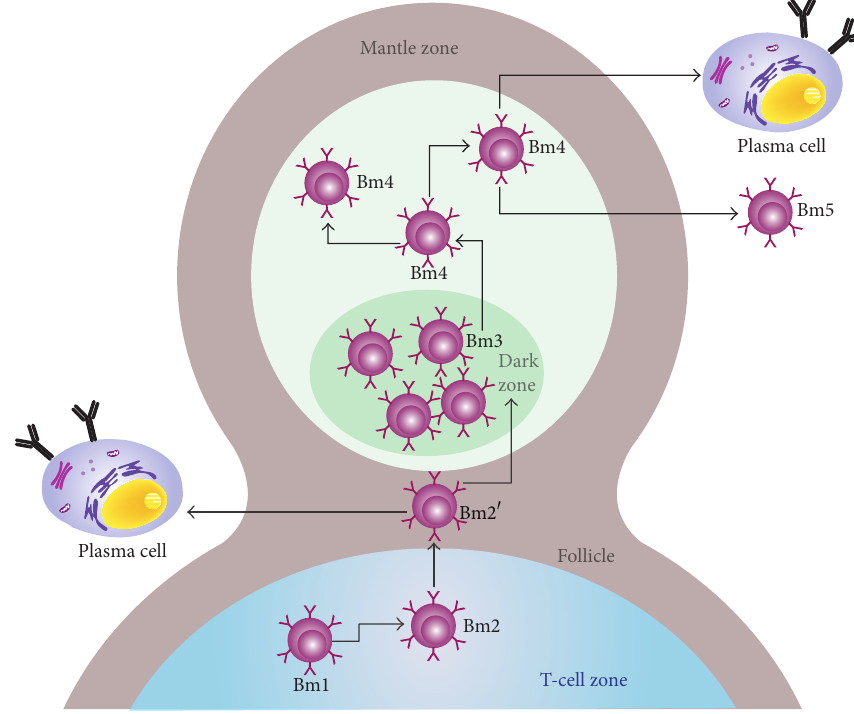
Figure 5: Germinal center (GC) changing a primary lymphoid follicle (LF) into a secondary LF. The GC is surrounded by the mantle zone, which is comprised of the light and dark zone, and populated by mature B (Bm) cells evolving from Bm1 in the T cell area through plasma cells that come back to the bone